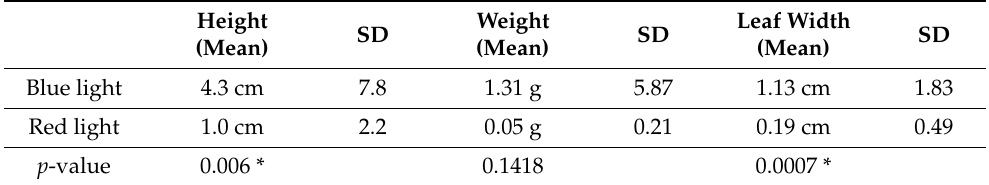
Table 4. The mean plant height, plant weight, and leaf width from the GrowBots with blue and red light. SD for standard deviation. * indicates statistical significance, p < 0.01.